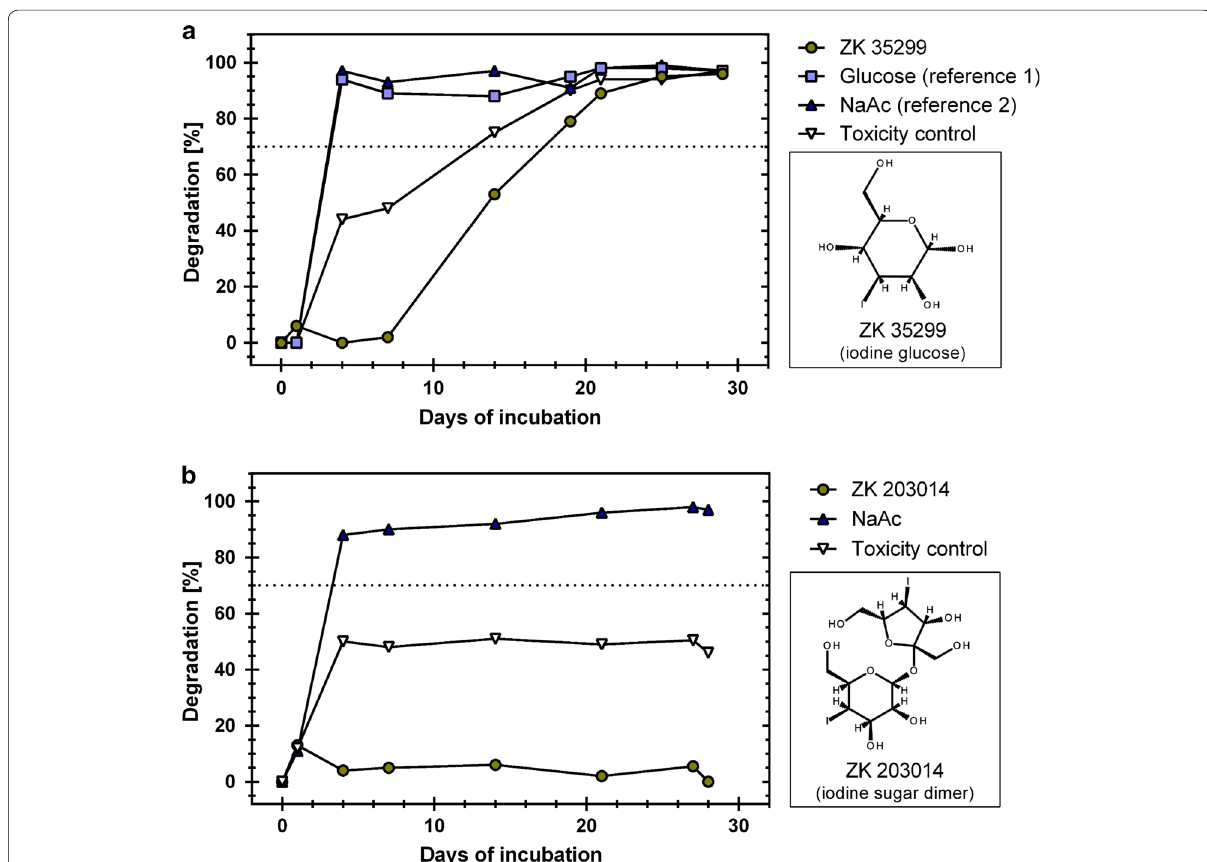
Fig. 2 Degradation of iodinated sugar molecules. a Iodinated glucose is less readily degraded than its parent compound glucose or the reference compound sodium acetate (NaAc), but still reaches ready biodegradability within the 21‑d window ( dashed line ). b The sugar dimer ZK 203014 with two iodines attached to achieve a higher radiocontrast shows only marginal biodegradability. In both graphs, the “Toxicity Control” depicts the result of the degradation of a 1:1 mixture of NaAc plus the test compound (ZK 35299 or ZK 203014). In both cases, these curves approximate the combination of the individual degradation curves of NaAc and the test compound, indicating that the test compound does not inhibit